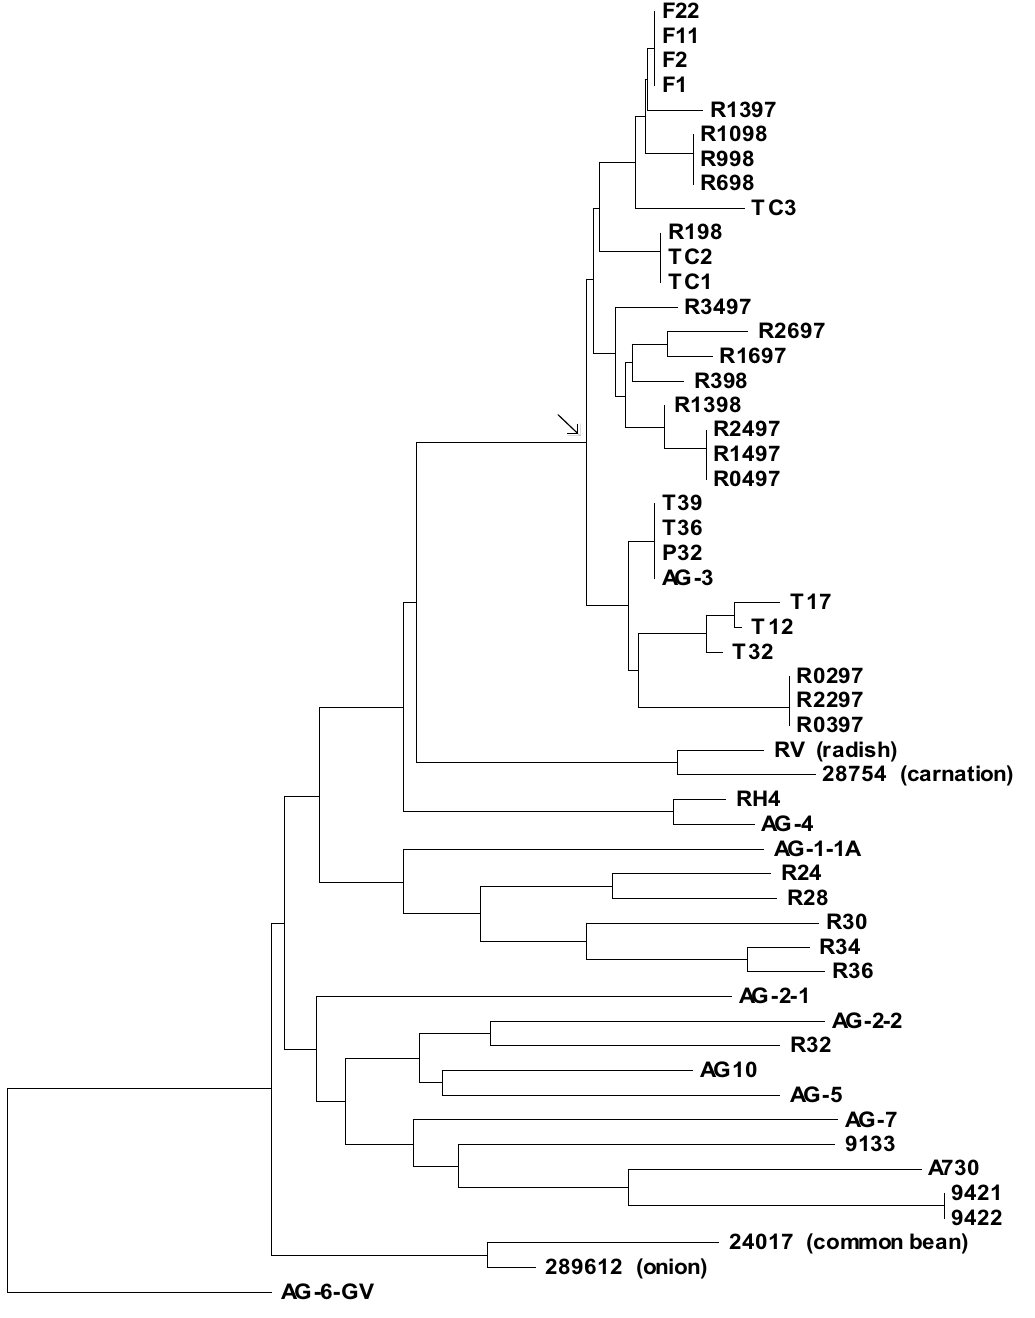
Fig. 5 . Dendrogram constructed from RAMS patterns of Rhizoctonia solani isolates using the neighbour-joining method from the distance matrix calculated and analysed as described in the text. Isolates codes and sources of the isolates are given in Table